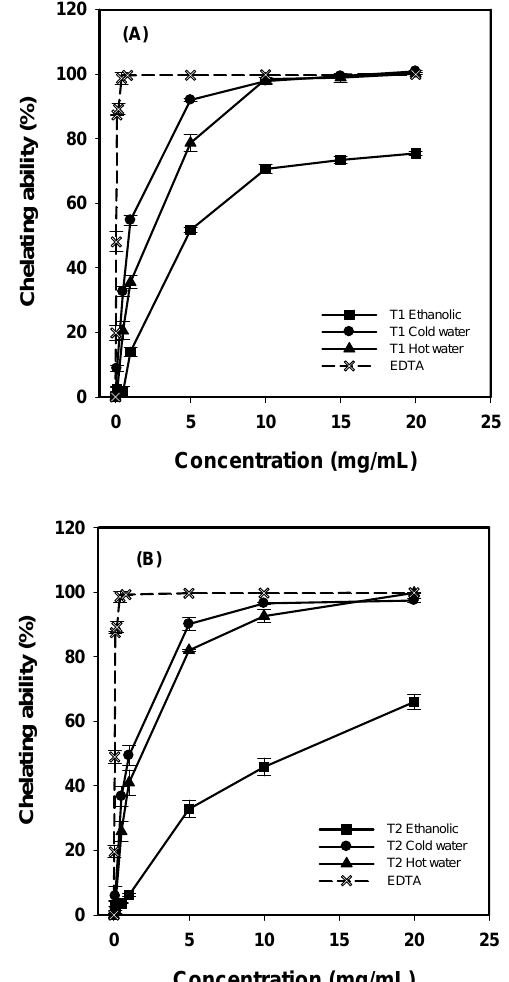
Figure 3. Chelating ability of various extracts from G. frondosa T1 (A), and G. frondosa T2 (B) on ferrous ions. Each value is expressed as mean ± S.D. (n =